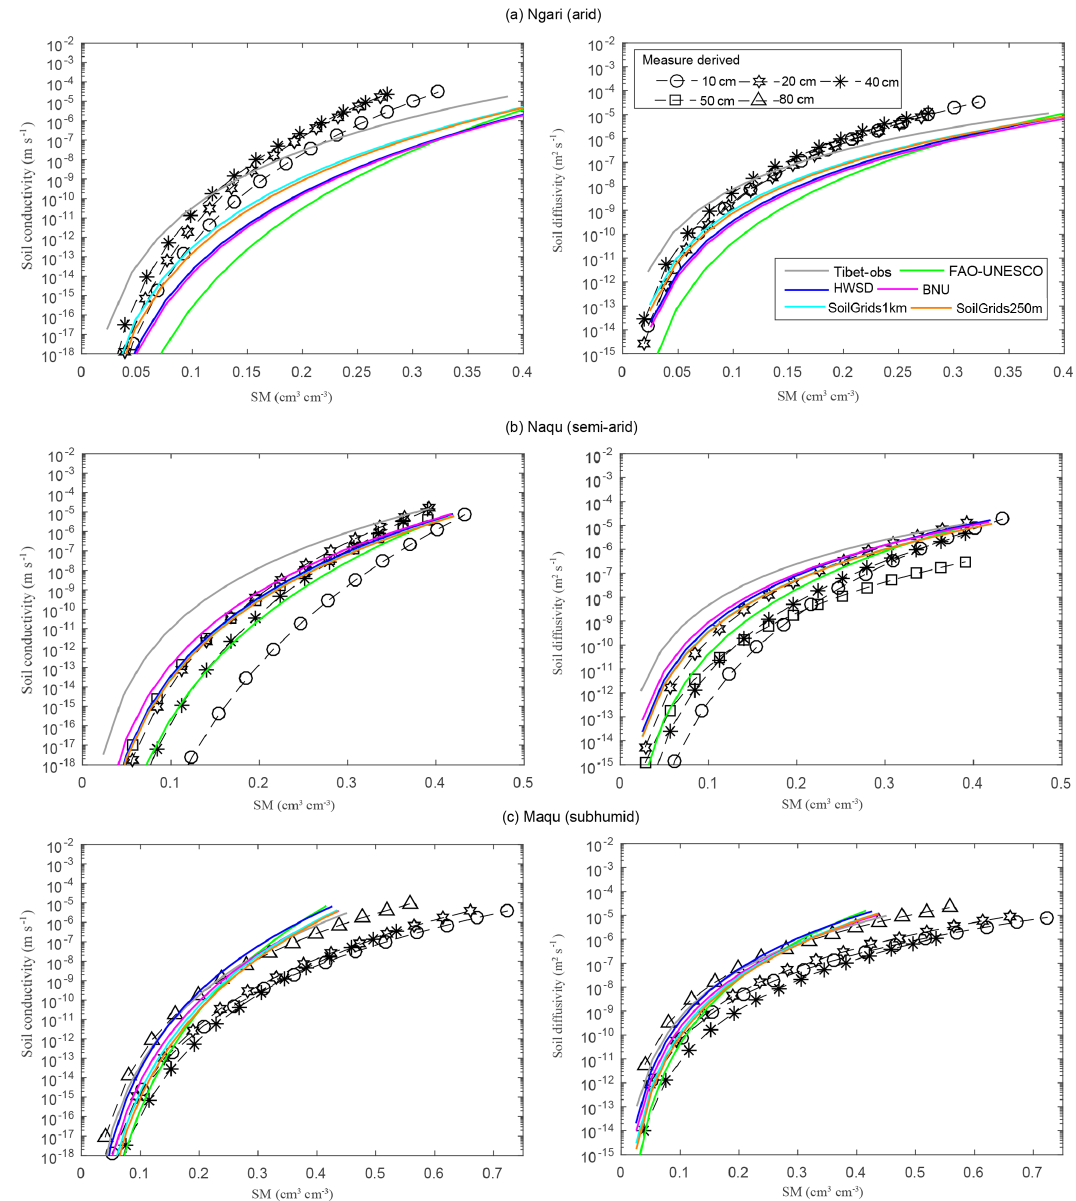
Figure A1. Comparisons of derived soil conductivity ( K ) and soil diffusivity ( D ) by the CH model based on six soil datasets with those derived from the laboratory measurements. Given the relatively homogenous soil profile derived from existing datasets (see Fig. 12 in the text), the averaged K and D derived from existing datasets over different depths were